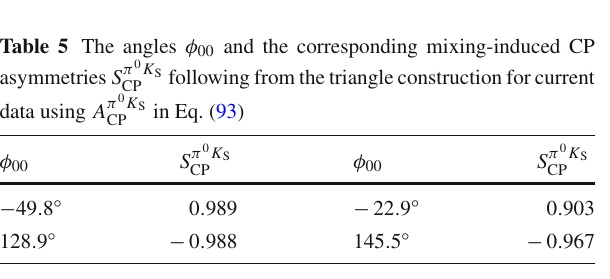
– S π 0 K S plane shown in Fig. 7 with the same colour CP CP